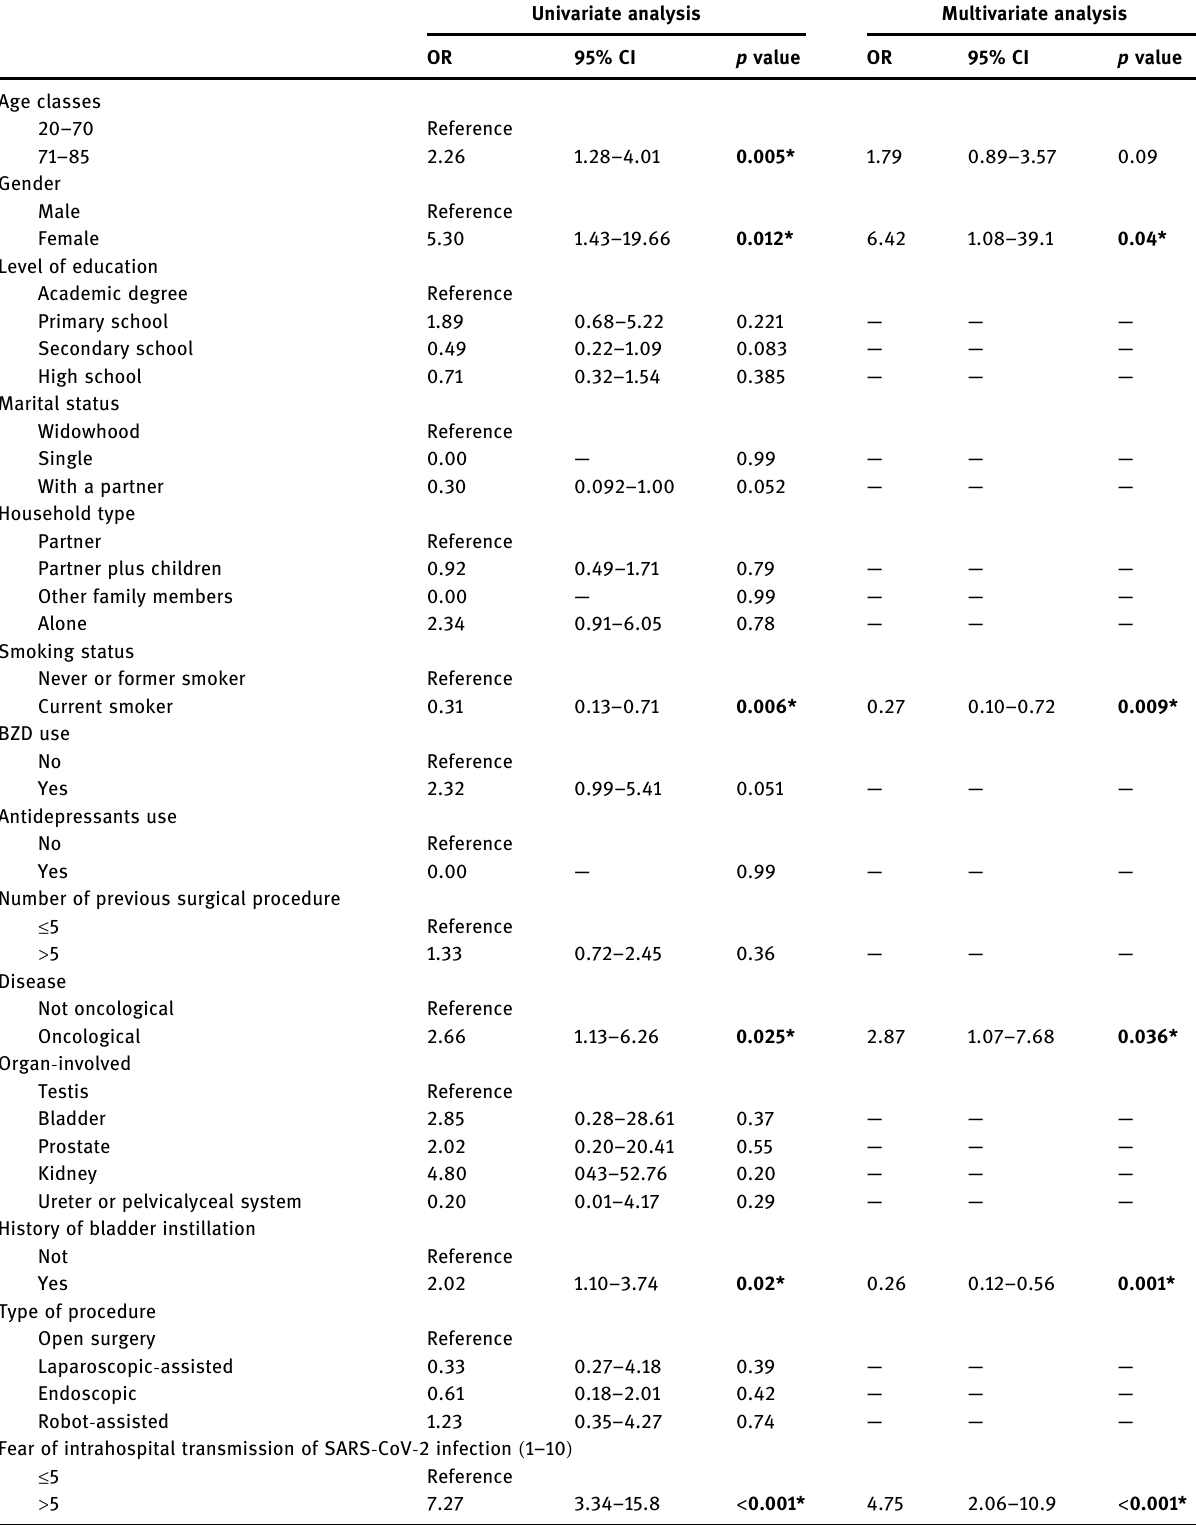
Table 4: Univariate and multivariate logistic regression analysis of clinical factors in predicting PSS - 4 ≥ 7 ( n = 87/200 – 43.5%